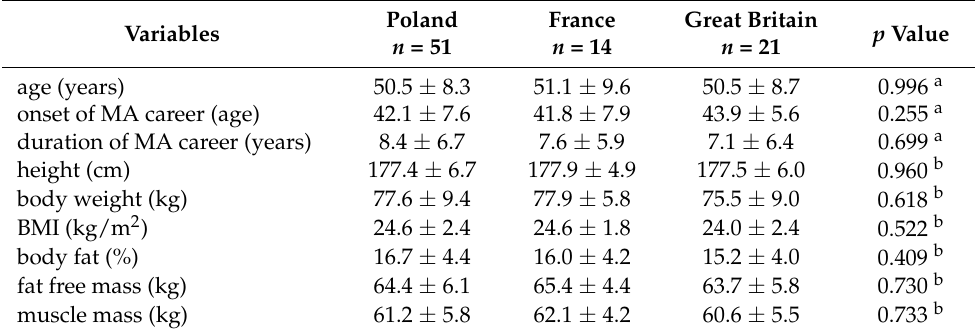
Table 1. Characteristics of masters athletics (arithmetic mean ± SD). Variables